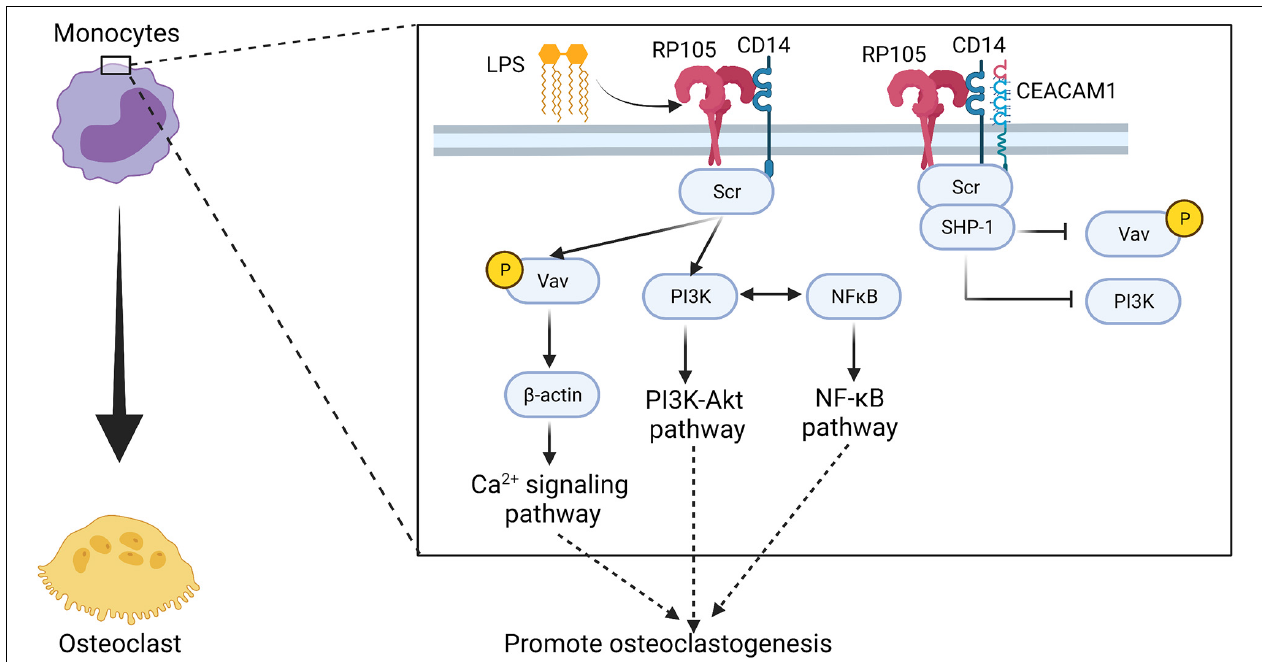
FIGURE 4 | Potential regulatory manner of RP105 in driving osteoclastogenesis of monocytes. RP105 may promote the differentiation of monocytes into osteoclasts via a RP105/MD-1/CD14/Src/Vav1/ β -actin axis (Zhang et al., 2019). At the same time, with the stimulation of LPS, RP105/MD-1/CD14/Scr also activates the PI3K-Akt pathway and induces crosstalk with the NF- κ B signaling pathway (Zhang et al., 2019). But, in presence of CEACAM1, SHP-1 recruitment blocks the tyrosine phosphorylation of Vav1, and sequestrates pVav and β -actin from the downstream signaling axis of RP105 (Zhang et al., 2019). Figure was created using